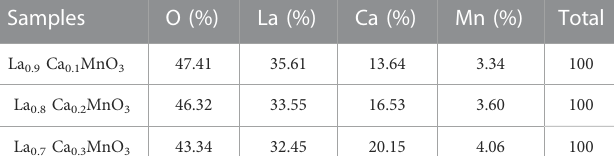
TABLE 1 Elemental composition of La 1-x Ca x MnO 3 (x = 0.1, 0.2, and 0.3). Samples